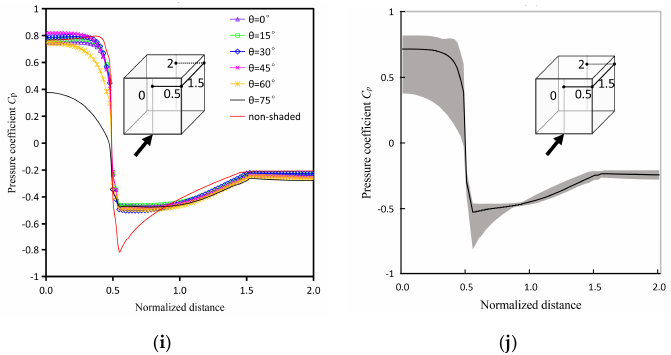
Figure 13. Local range R , local and average value of wind pressure coefficient C p for different shaded conditions on the central lines of different floors along the windward, lateral and leeward surfaces. ( a ) Local value along F1; ( b ) Local range R and average value along F1; ( c ) Local value along F2; ( d ) Local range R and average value along F2; ( e ) Local value along F3; ( f ) Local range R and average value along F3; ( g ) Local value along F4; ( h ) Local range R and average value along F4; ( i ) Local value along F5; ( j ) Local range R and average value along F5.